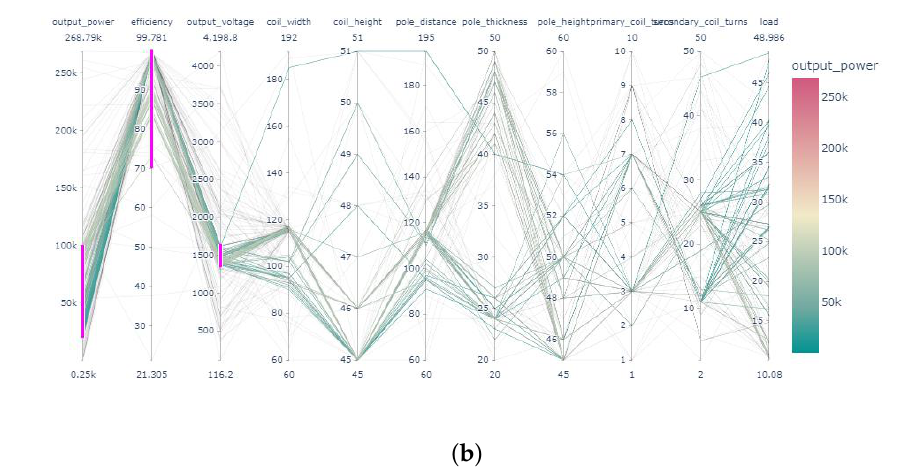
Figure 13. PCP of optimal analysis example as ( a ) overall display and ( b ) highlight